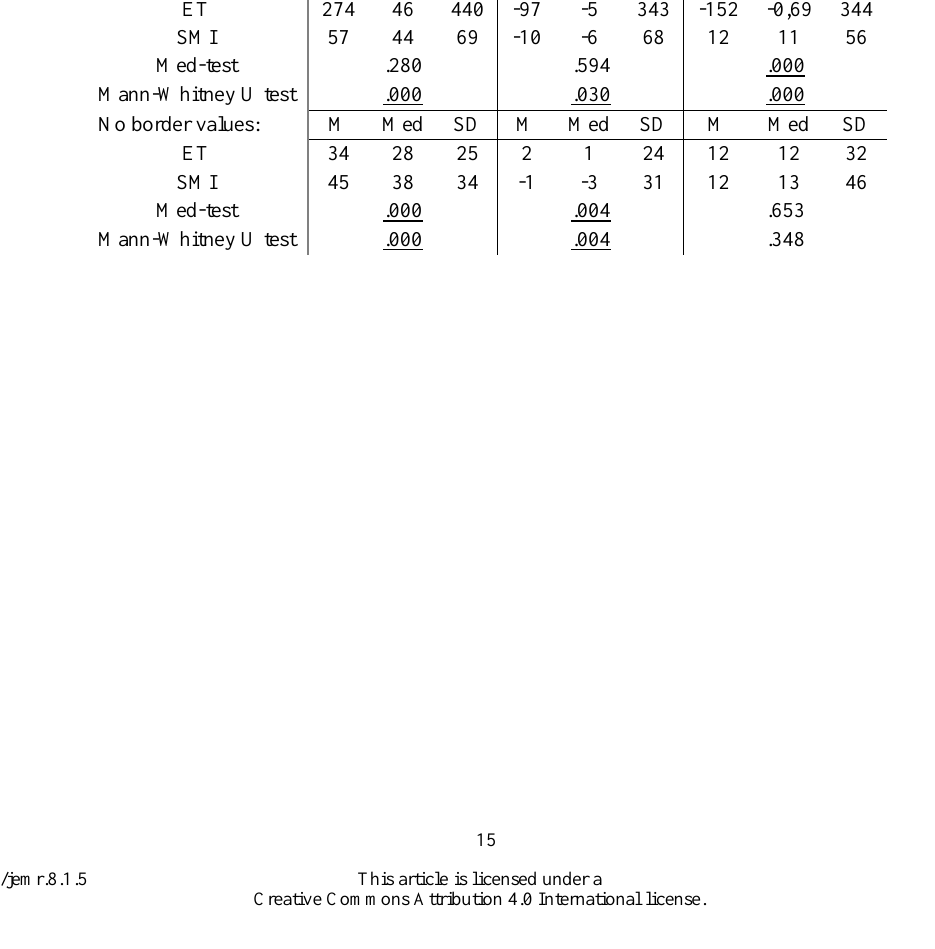
Table 3: Statistical comparison of the registered offset values (with and without border values) dist distX distY All